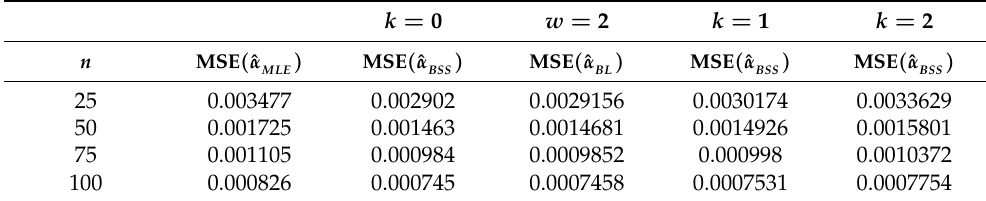
Table A5. Simulated MSE of ˆ α using Uniform b over [0, 1], β = 0.9, u = 4 and v =